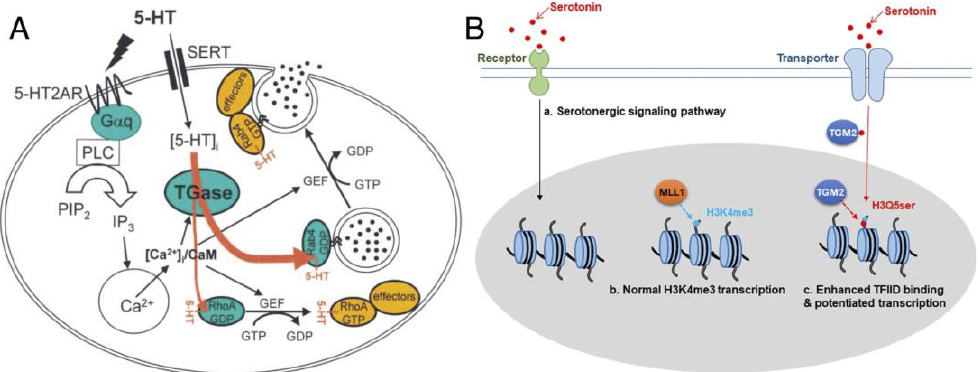
Figure 3. Examples of protein serotonylation: ( A ) Serotonylation of small GTPases. Upon stimulation of platelets by 5-HT, the phosphatidyl inositol pathway is activated, resulting in a rise of cytoplasmic Ca 2+ . 5-HT signaling is mediated by the G-protein-coupled 5-HT2AR and by transport into the cytoplasm by SERT. The contents of ⍺ -granules are released into circulation (for example, vWf, black circles) or exposed at the plasma membrane; figure reproduced from [15] (© 2003 Cell Press). ( B ) Regulation model of 5-HT and effect of histone H3 serotonylation, reproduced from Fu et al. [44] (distributed under the terms of the Creative Commons Attribution 4.0 International License, available creativecommons.org/license/by/4.0). The H3K4me3Q5ser double modification enhances the interaction of histone with certain H3K4me3 “ reader ” proteins, such as TFIID, and then reinforces permissive patterns of gene expression.